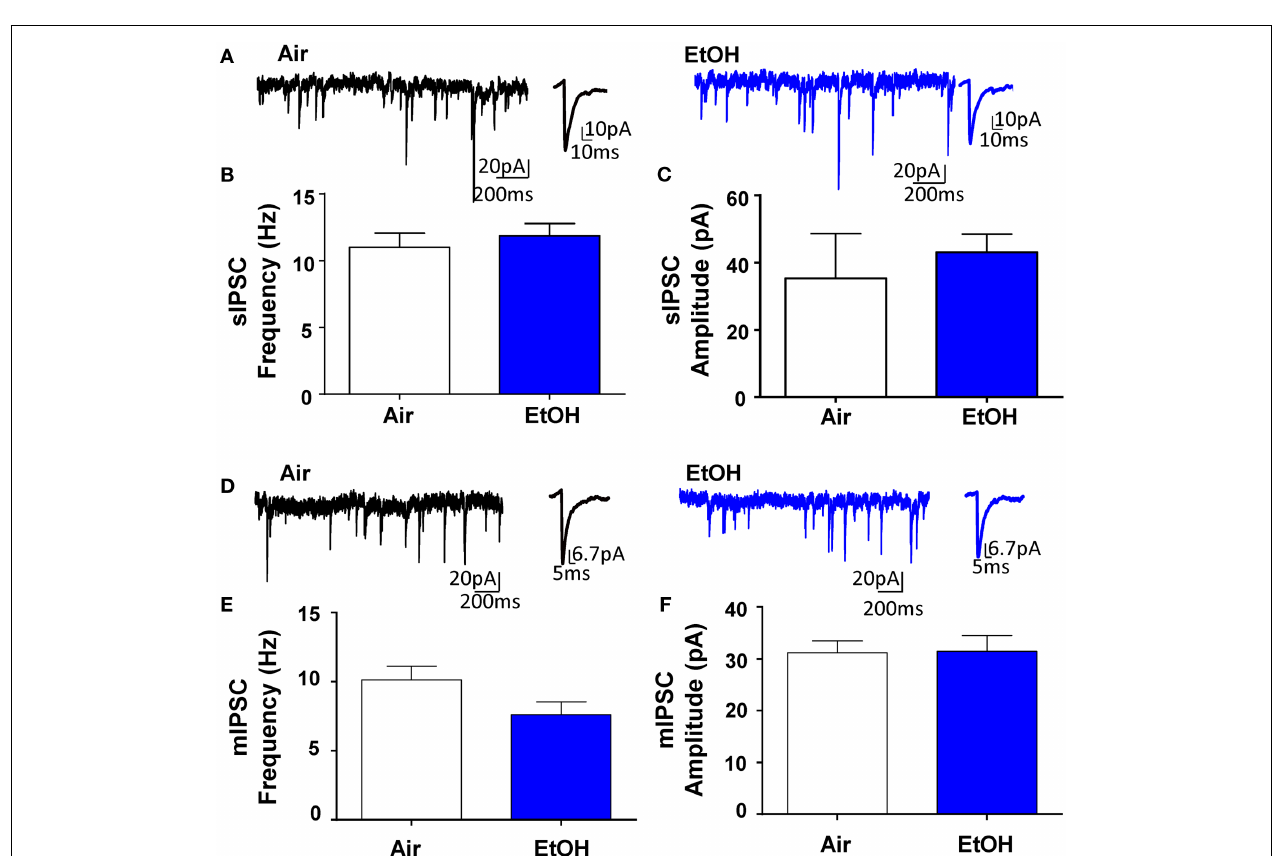
from 5 Air and 5 EtOH litters, p > 0.05 by unpaired t -test). (D) Exemplar compressed traces of mIPSC recordings obtained under baseline conditions (in the presence of 1 µ MTTX) from Air (black) and EtOH (blue) exposed animals. Exemplar expanded scale traces of averaged mIPSCs are shown adjacent to compressed traces. Basal mIPSC (E) frequency and (F) amplitude were not significantly different between Air- and EtOH-exposed animals ( n =